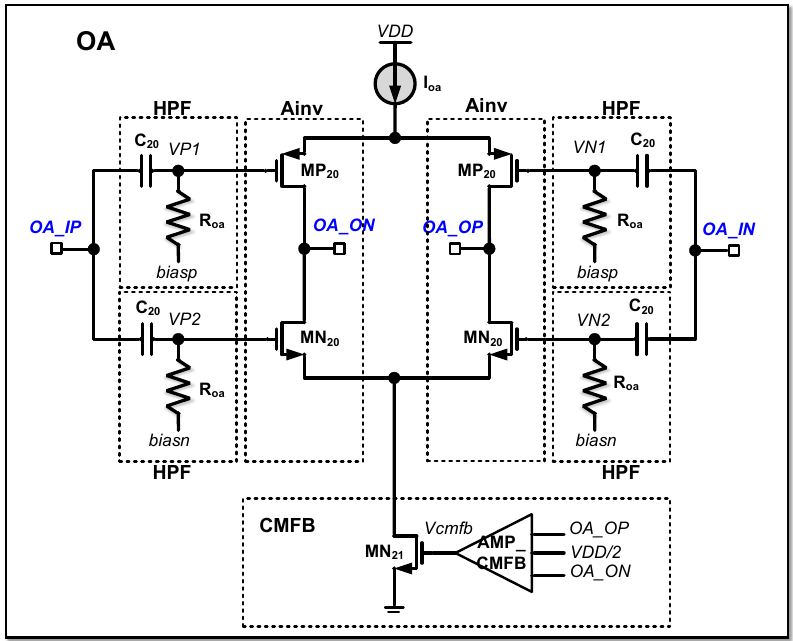
Figure 8. Detailed circuit diagram of the open-loop amplifier (OA).